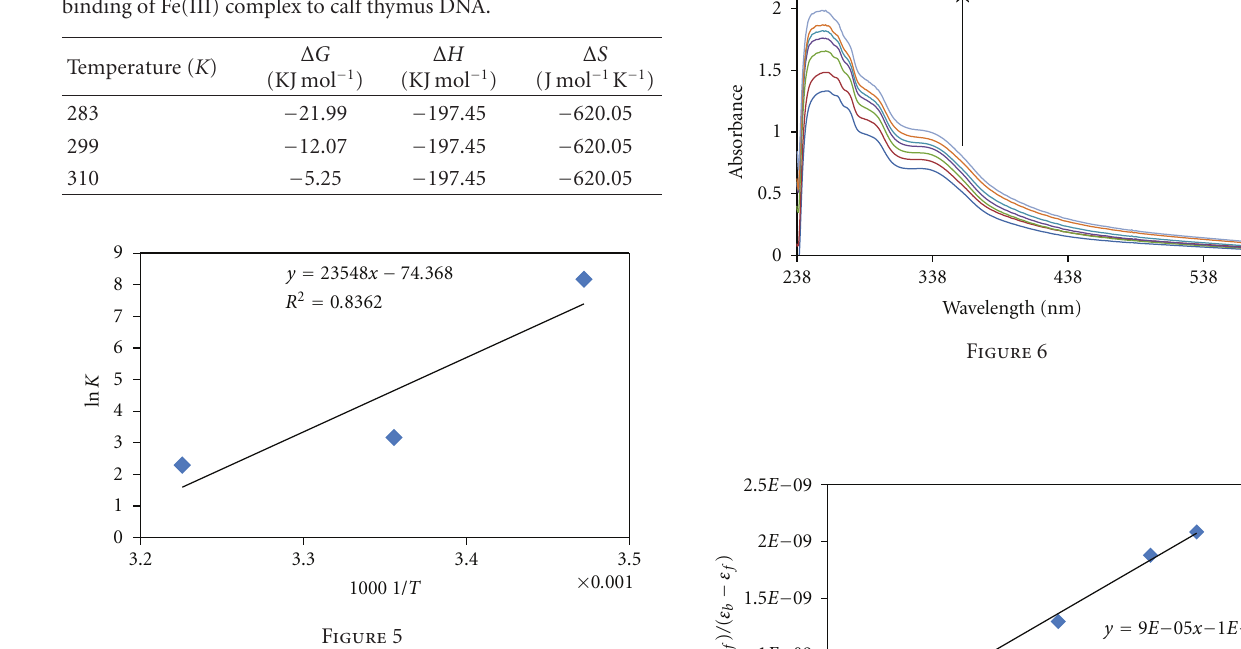
Table 3: Thermodynamic parameters and binding constants for the binding of Fe(III) complex to calf thymus